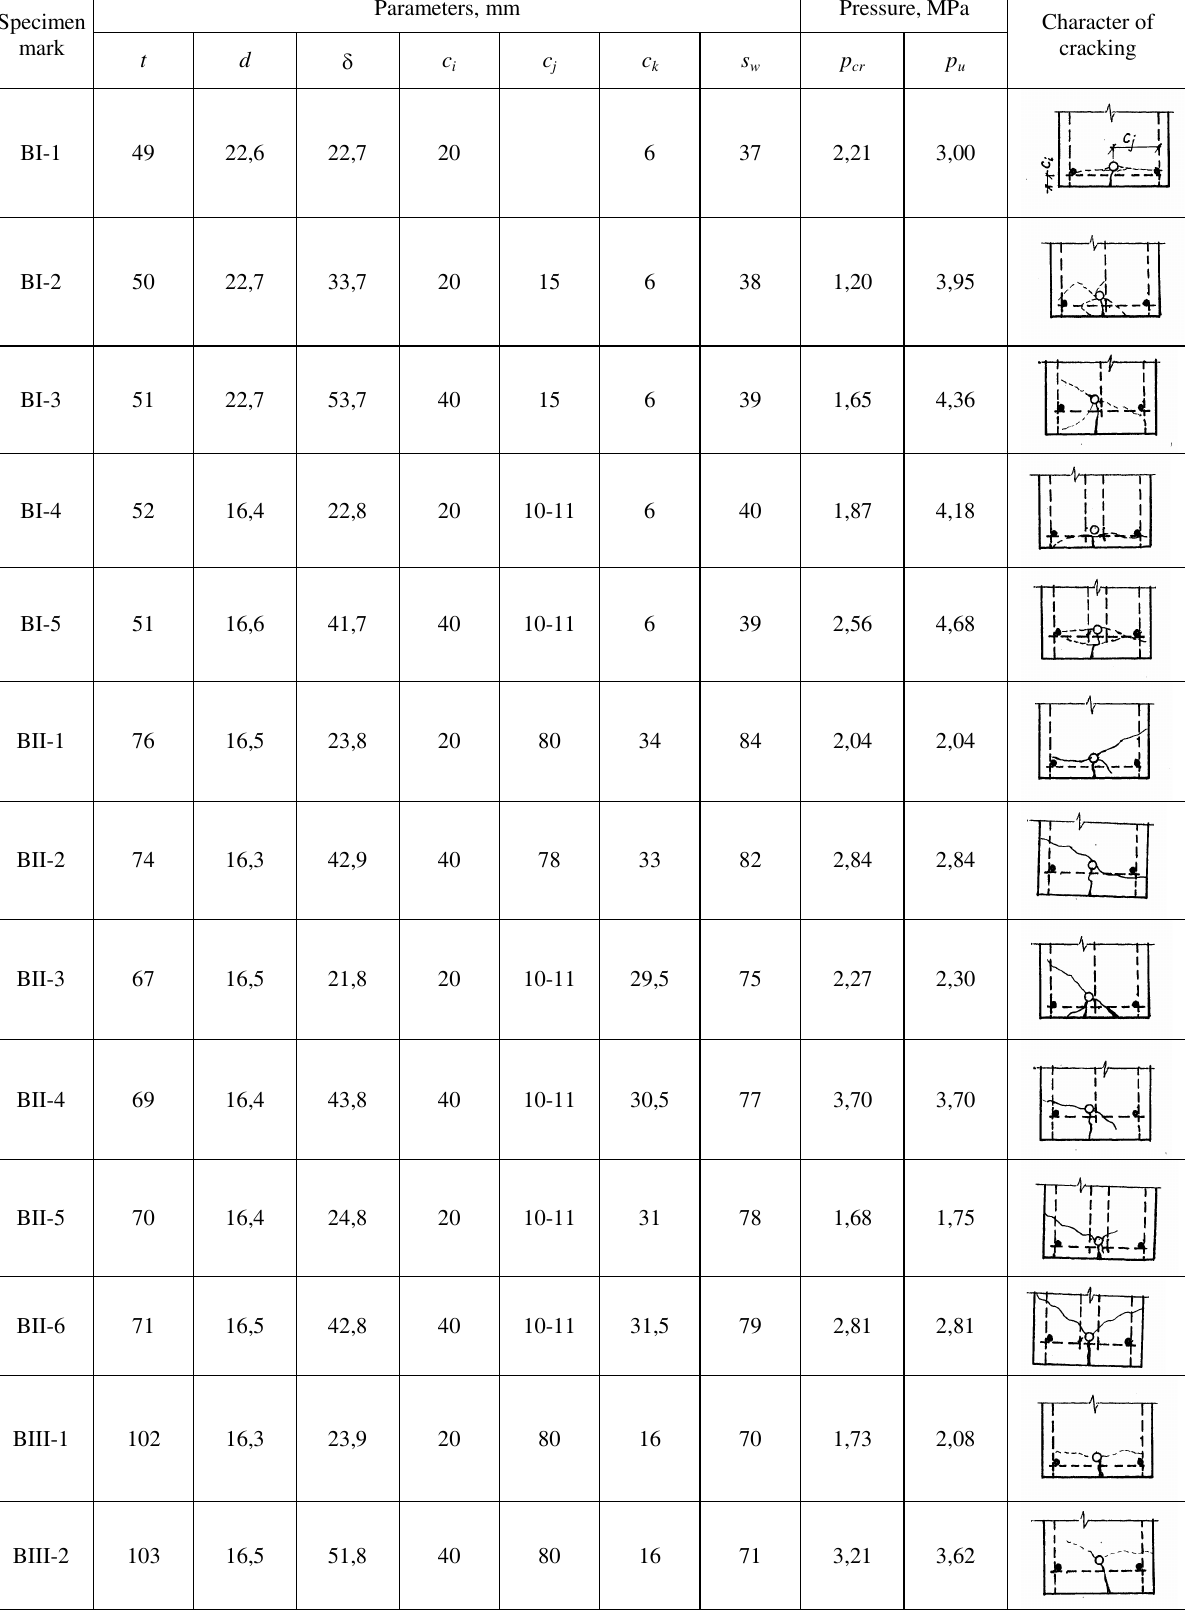
Table 2. Parameters of the specimens and investigation results Parameters, mm Pressure, MPa Specimen Character of